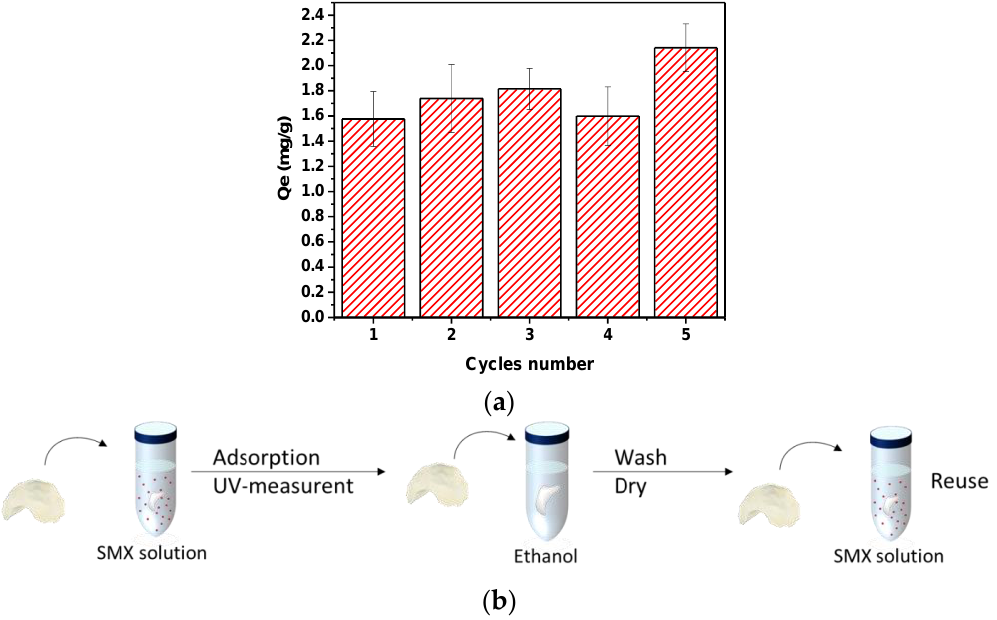
Figure 10. Adsorption capacity of TMPES and P4VP-PEO-modified CNFs films after different adsorption cycles of 25 ppm SMX for 1 h equilibrium time ( a ). Schematic of the reusability process of the modified films ( b ).